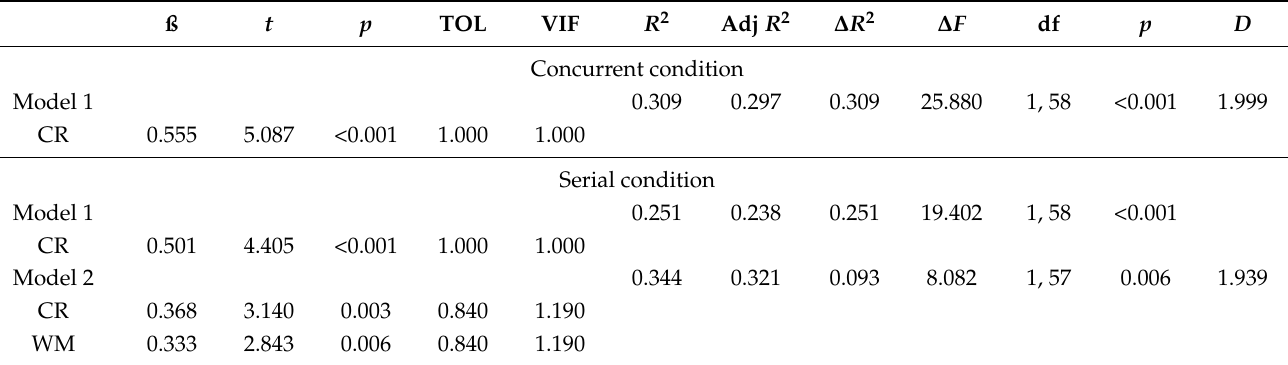
Table 4. Results of the stepwise regression analyses for